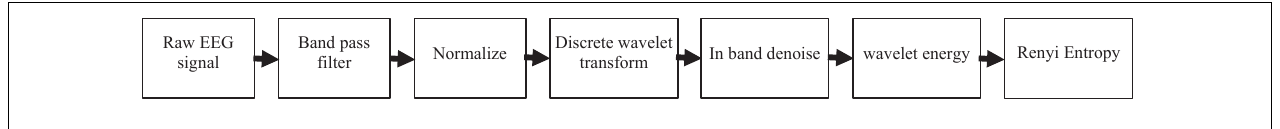
FIGURE 2 | EEG processing flow diagram.